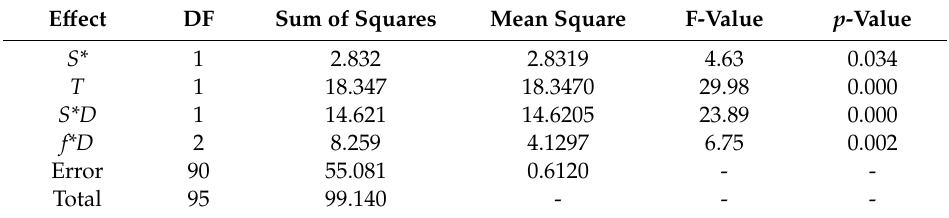
Table 5. Analysis ANOVA of the transformed Ra. DF = degrees of